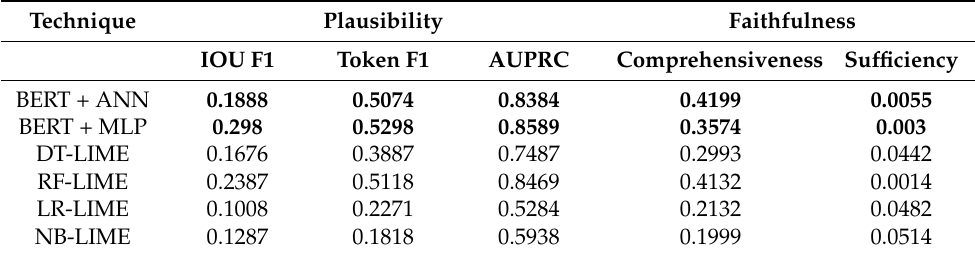
Table 9. Explainability